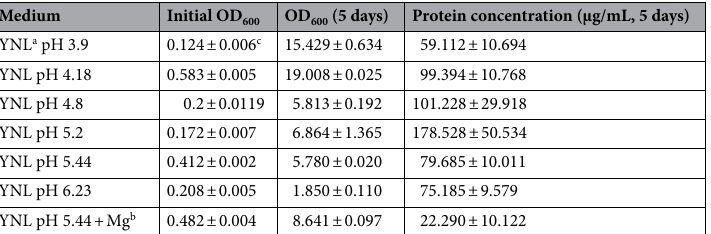
2 was present in the YNL